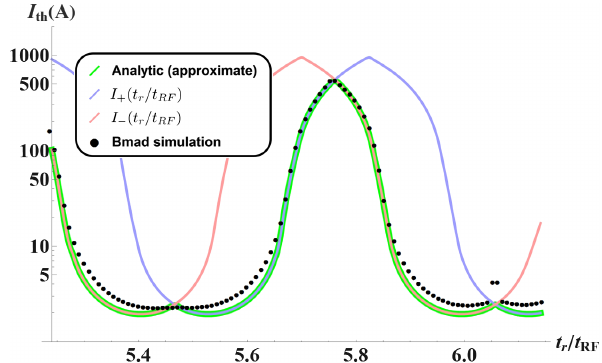
FIG. 19. Comparison of the I obtained from the approximate th analytic formula [Eq. (19)], the two candidates [Eq. (20)], and the BMAD simulation for the case D2. The parameters used are identical as in the case D1, except for the